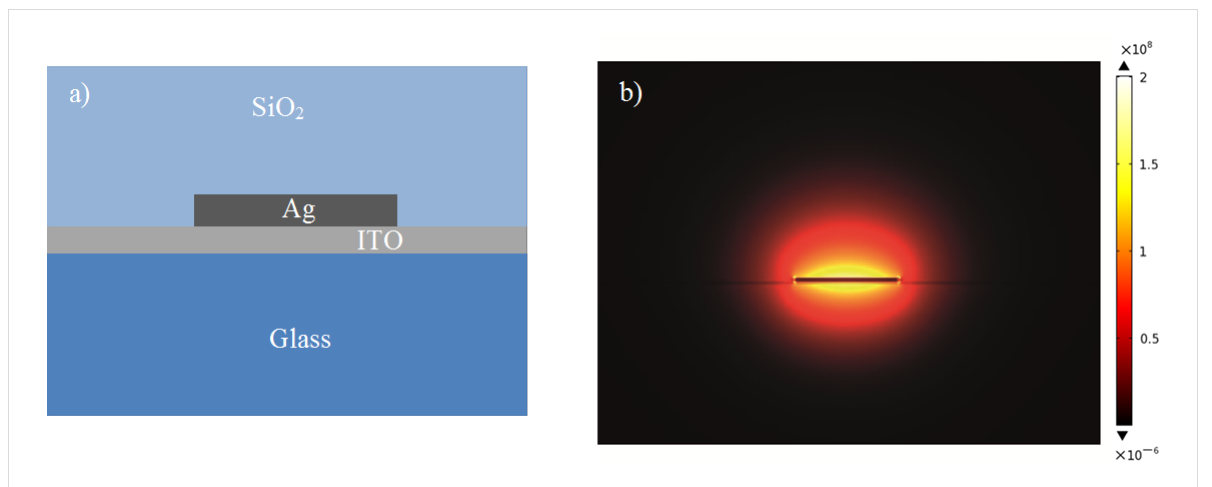
Figure 1: (a) The schematic diagram of the stripe waveguide covered with SiO 2 on an ITO-coated glass substrate, and (b) The magnitude of the elec- tric field of the bound LRSPP mode supported by a 750 nm wide, 30 nm thick silver stripe waveguide on an ITO coated glass substrate at an excita- tion wavelength of 633